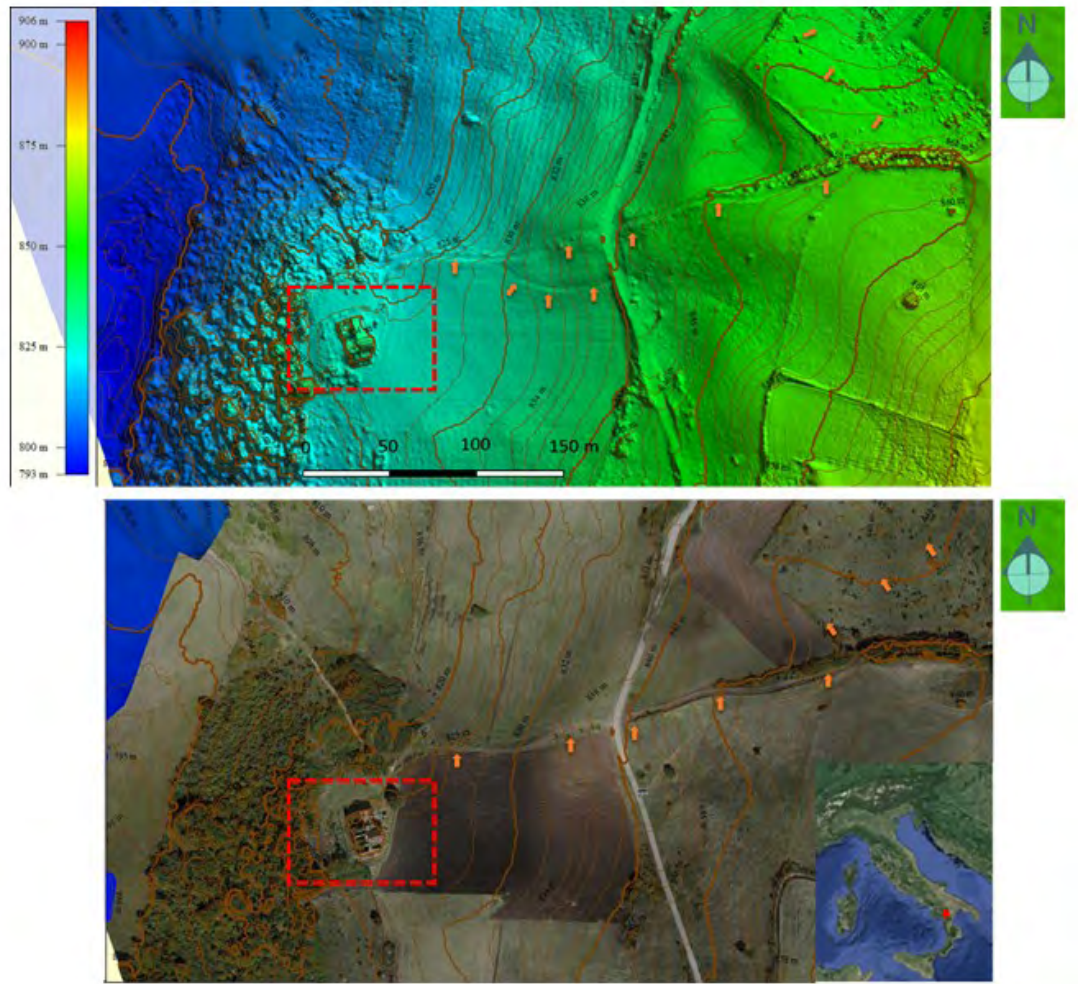
Figure 1. Digital Surface Model and orthophoto provided by the processing of images taken from drone. The orange arrows denote the presence of some features of possible cultural interest such as old roads and field divisions. The dashed rectangu- lar box indicates the investigated area. Lower right: Location of